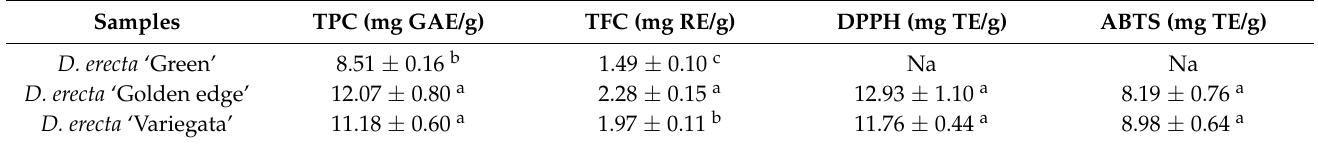
Table 2. Total phenolic (TPC), flavonoid (TFC), and radical scavenging (DPPH and ABTS) abilities of the tested oils.